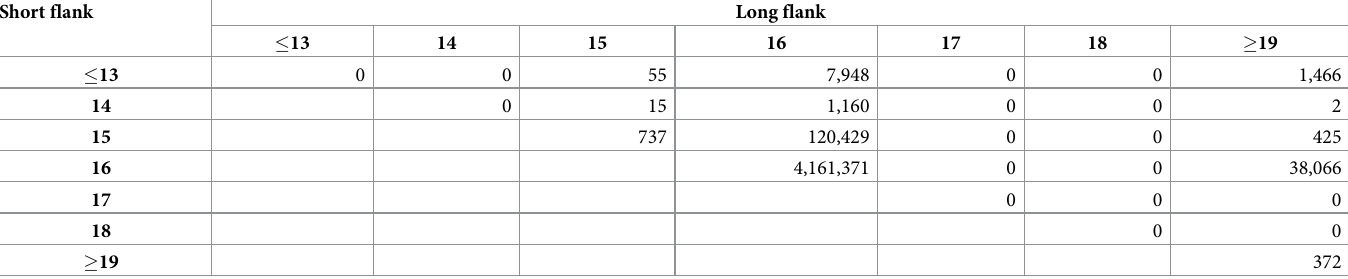
Table 4. Flank length analysis of base-filtered reference-matching, motif-containing reads derived from Illumina DHB4 run. Short